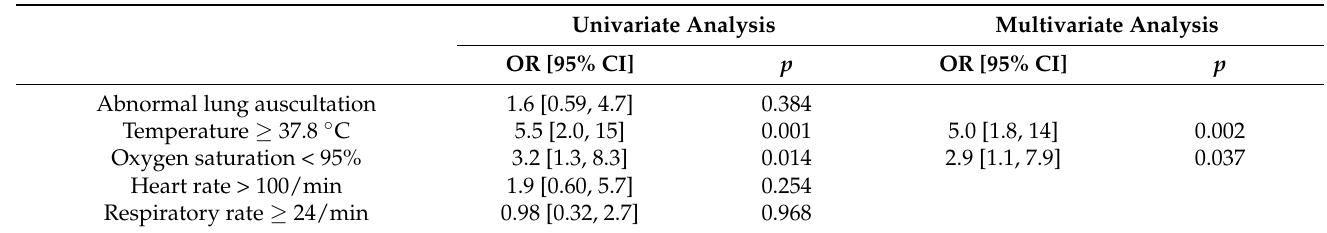
Table 2. Logistic regression analyses: association of vital signs and lung auscultation with pneumonia visible on chest X-ray